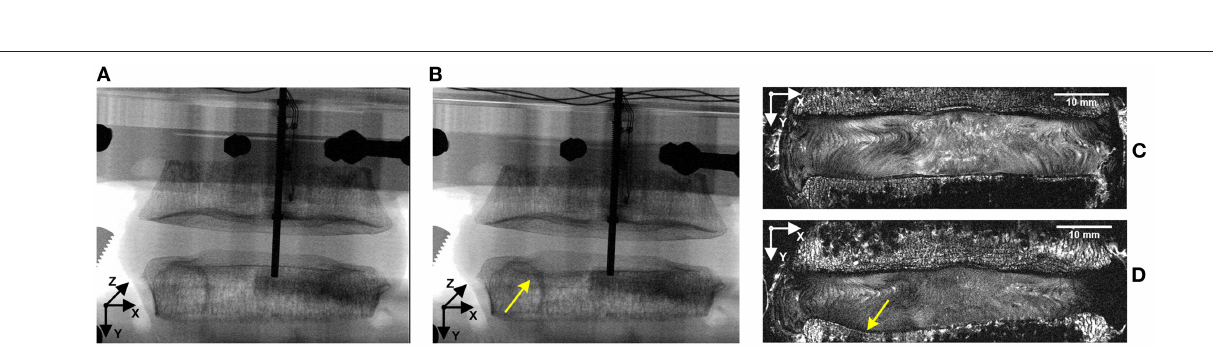
FIGURE 6 | Comparisons of strains seen in specimens with (A) outward bulging of the inner AF (Group OB) and (B) inward bulging of the inner AF (Group IB). (A,B) show schematics of the outward and inward bulge of the inner AF, respectively. (i) shows the mid-coronal MRI slice of typical specimens in each group, with (ii) showing the left and right lateral regions with yellow dashed lines delineating the morphology of lamellae. The MRI slice, with superimposed minimum 3D principal strains and maximum 3D shear strains are shown in (iii) and (iv) , respectively. (C) compares the 3D principal and 3D shear strains in the two groups and (D) compares the axial and minimum principal strains in the two groups. Error bars represent standard deviations.